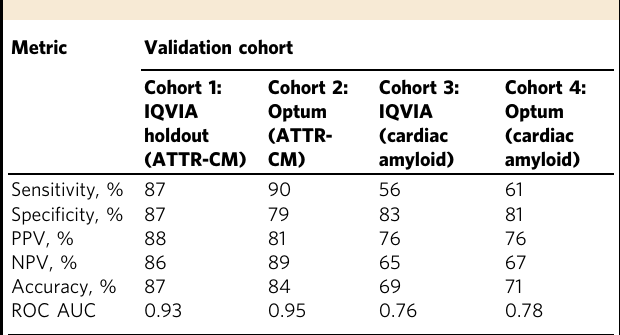
Table 2 Validation of the machine learning model in four cohorts derived from medical claims and electronic health